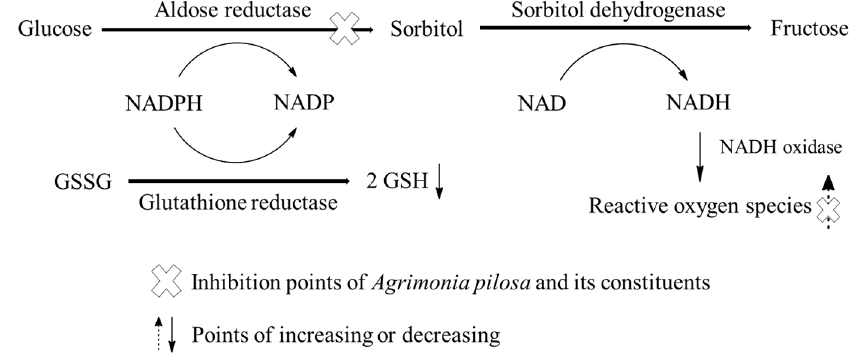
Figure 5. Inhibition points of A. pilosa Ledeb and its constituents on polyol pathway. GSH: glutathione, GSSG: glutathione disulfide, NAD: nicotinamide adenine dinucleotide, NADH: oxidoreductase-induced nicotinamide adenine dinucleotide, NADP: nicotinamide adenine dinucleotide phosphate, NADPH: oxidoreductase-induced nicotinamide adenine dinucleotide phosphate.